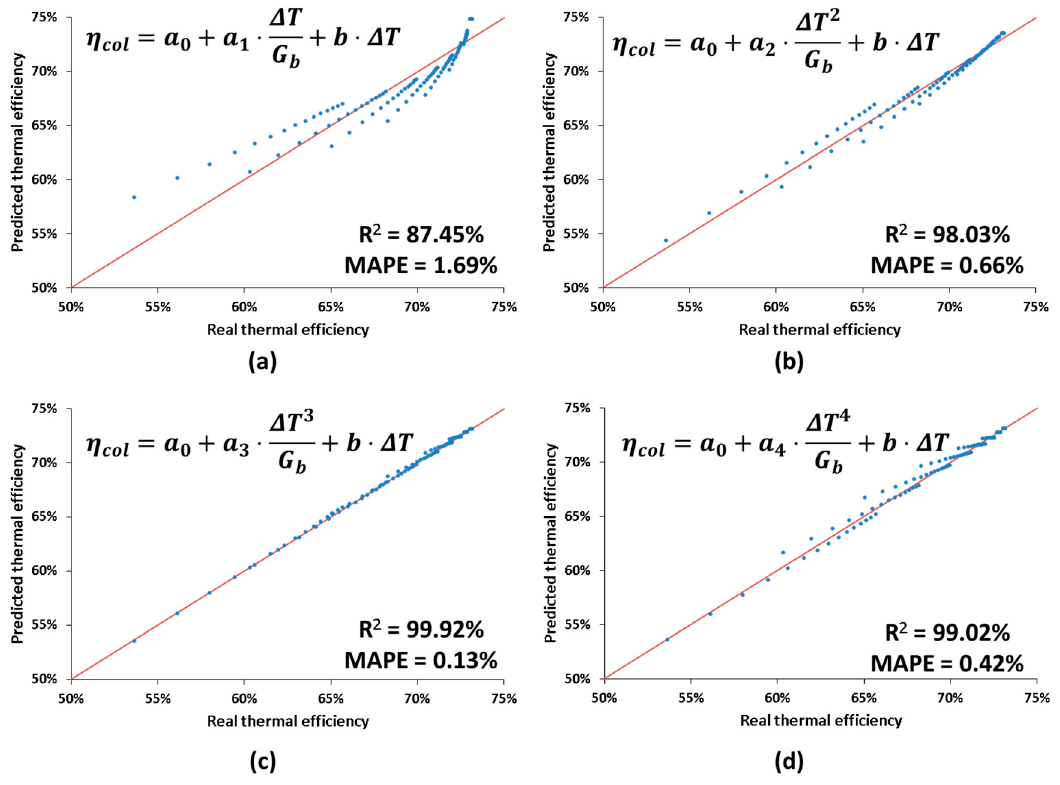
ffi ciency equations of the form “ a